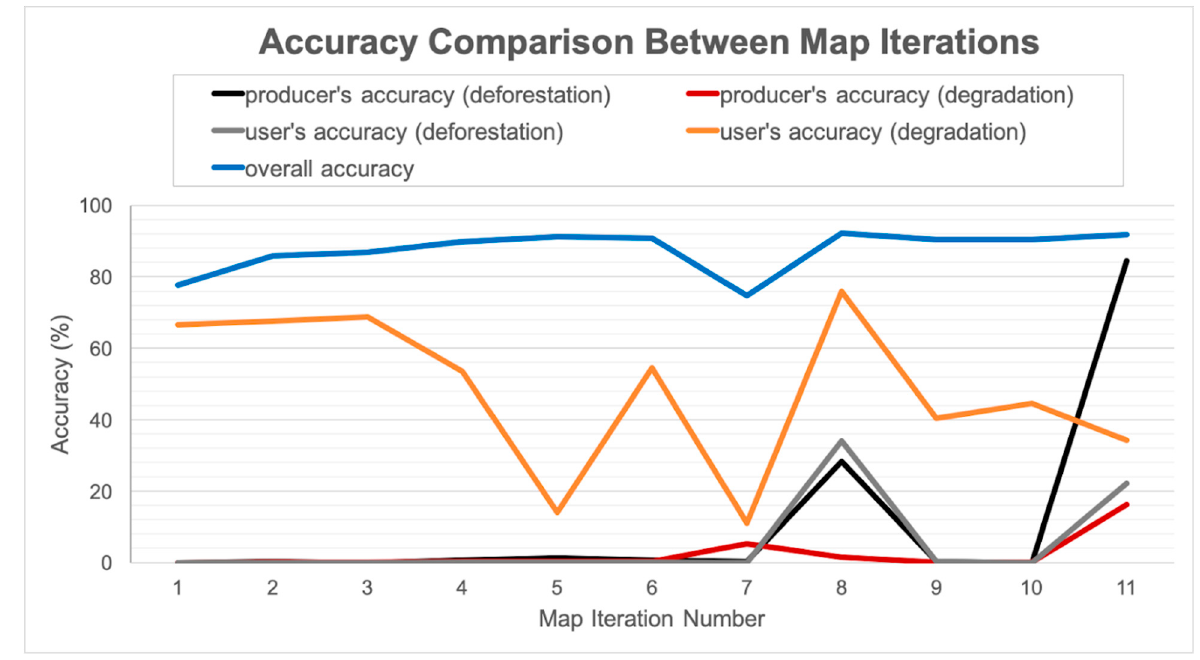
Figure 2. Comparison of overall map accuracy and user’s and producer’s accuracy for the map iterations of CODED described in Table 1.